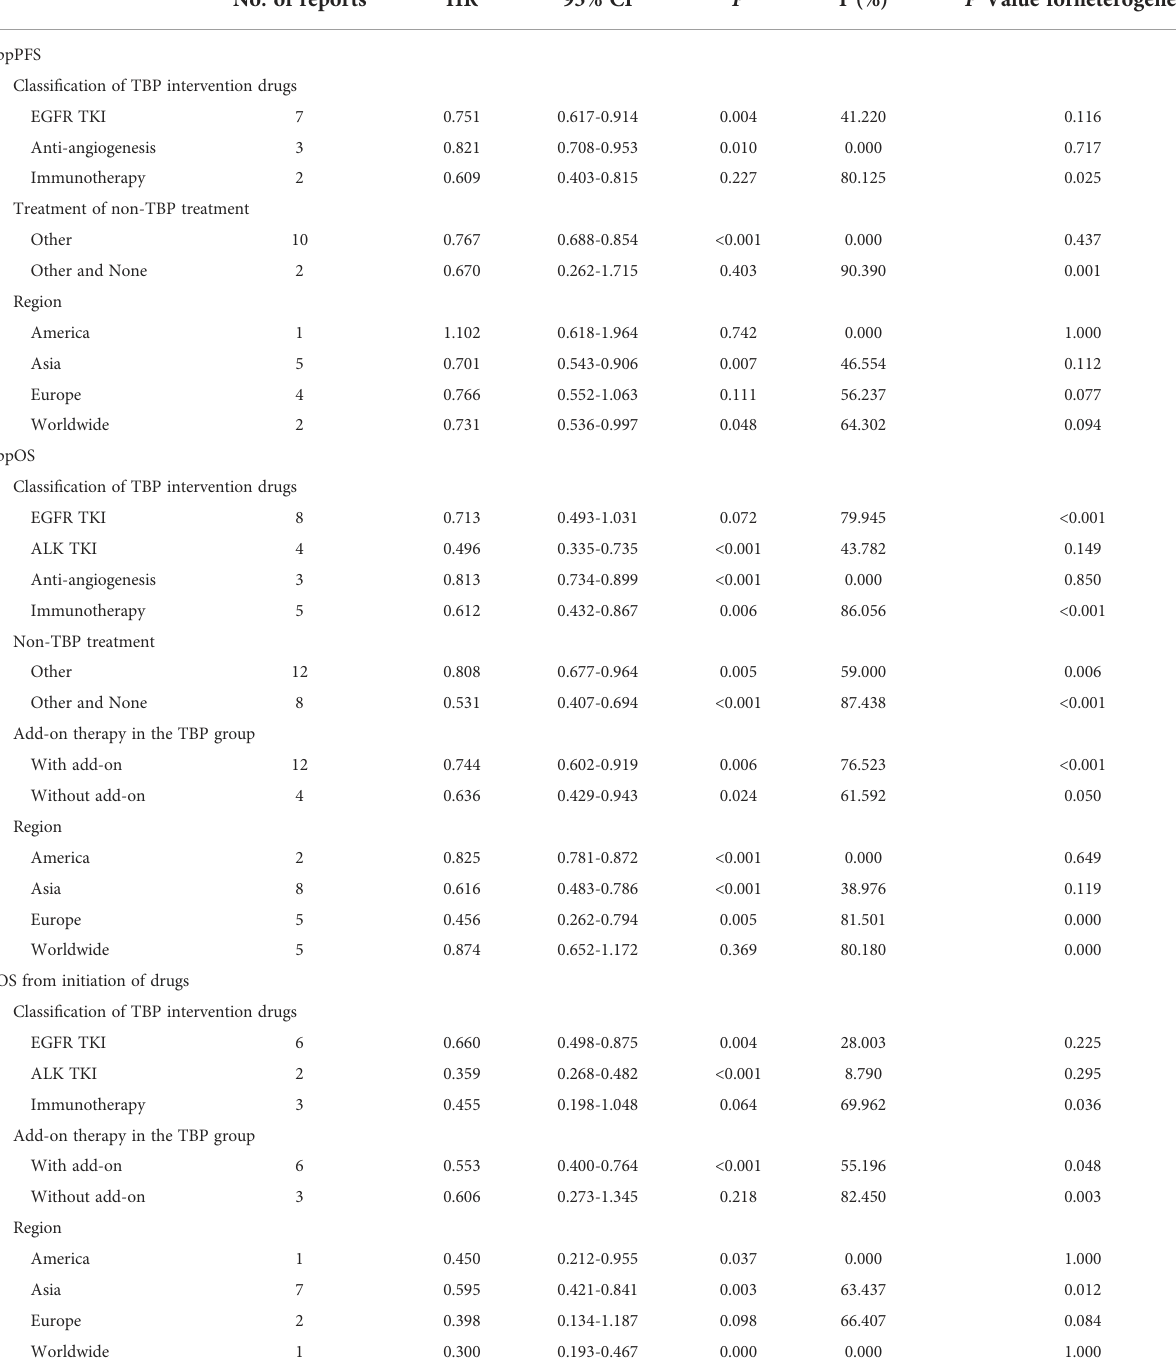
TABLE 2 Differences of survival outcomes by subgroups. No. of reports HR 95% CI P I 2 (%) P Value